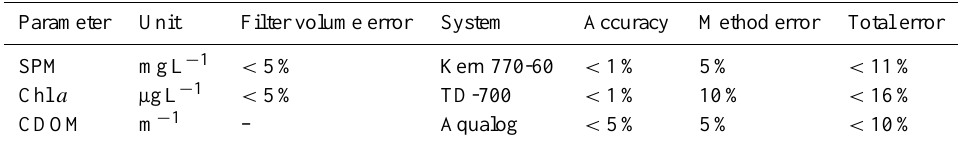
Table 2. Uncertainties and accuracy for laboratory methods and instruments. Parameter Unit Filter volume error System Accuracy Method